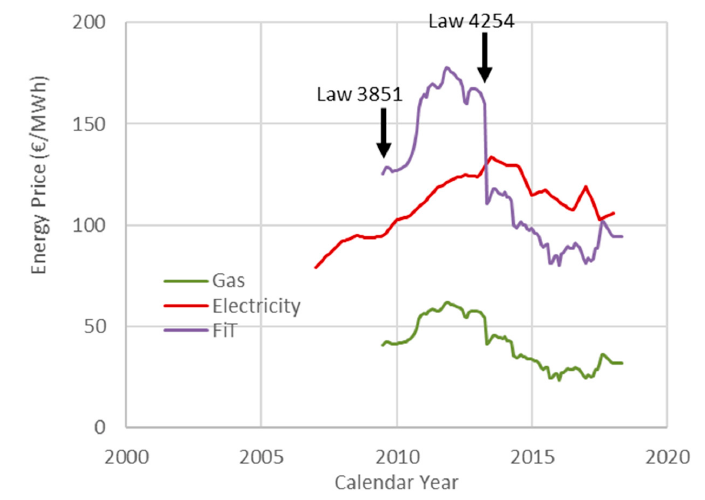
Figure 2. Electricity and gas prices. Feed-in tariffs for CHP systems, Greece, 2002–2018.